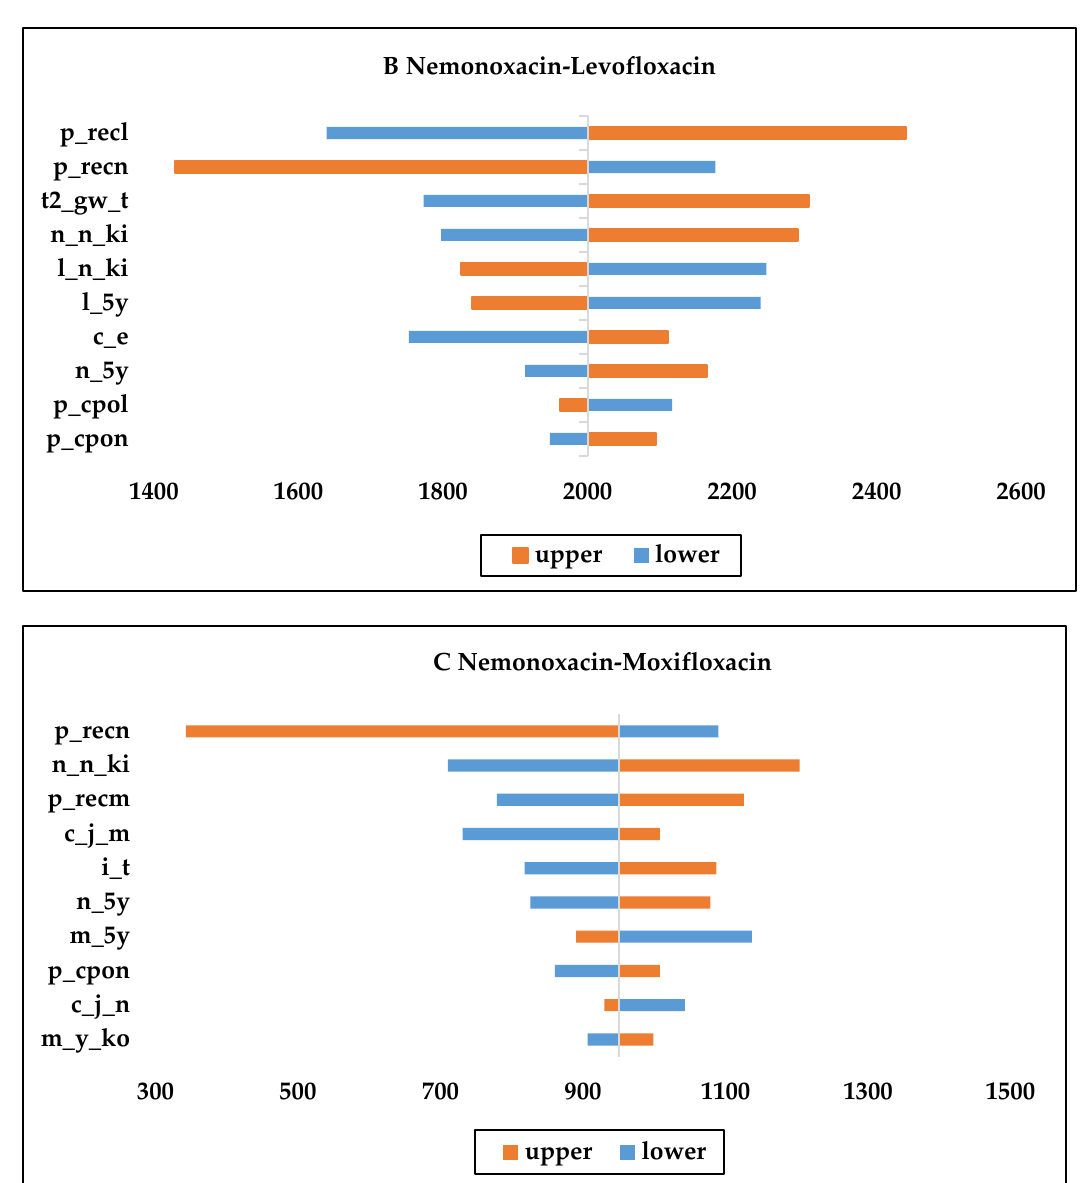
Figure 2. One-way sensitivity analysis chart. (c_j_m: daily cost of moxifloxacin injection; c_j_n: daily cost of nemonoxacin injection; c_e: daily cost of second-line therapy; m_5y: Moxifloxacin initial treatment effective rate; l_5y: Levofloxacin initial treatment effective rate; n_5y: Nemonoxacin initial treatment effective rates; n_ki: proportion of original drug treatment after initial failure of levofloxacin; n_n_ki: proportion of original drug treatment after initial failure of nemonoxacin; i_t: initial treatment day; t2_gw_t: second-line treatment days in general; p_recm: recurrence rate for moxifloxacin after effective initial treatment; p_recl: recurrence rate for levofloxacin after effective initial treatment; p_recn: recurrence rate for nemonoxacin after effective initial treatment; p_cpol: initial treatment effect delay rate for levofloxacin; p_cpon; initial treatment effect delay rate for nemonoxacin; m_y_ko: sequential proportion of hospitalizations after successful initial treatment with